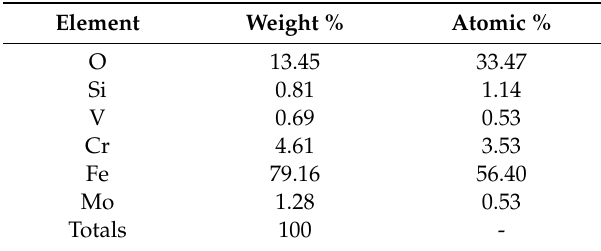
Table 3. EDS analysis of area A in Figure